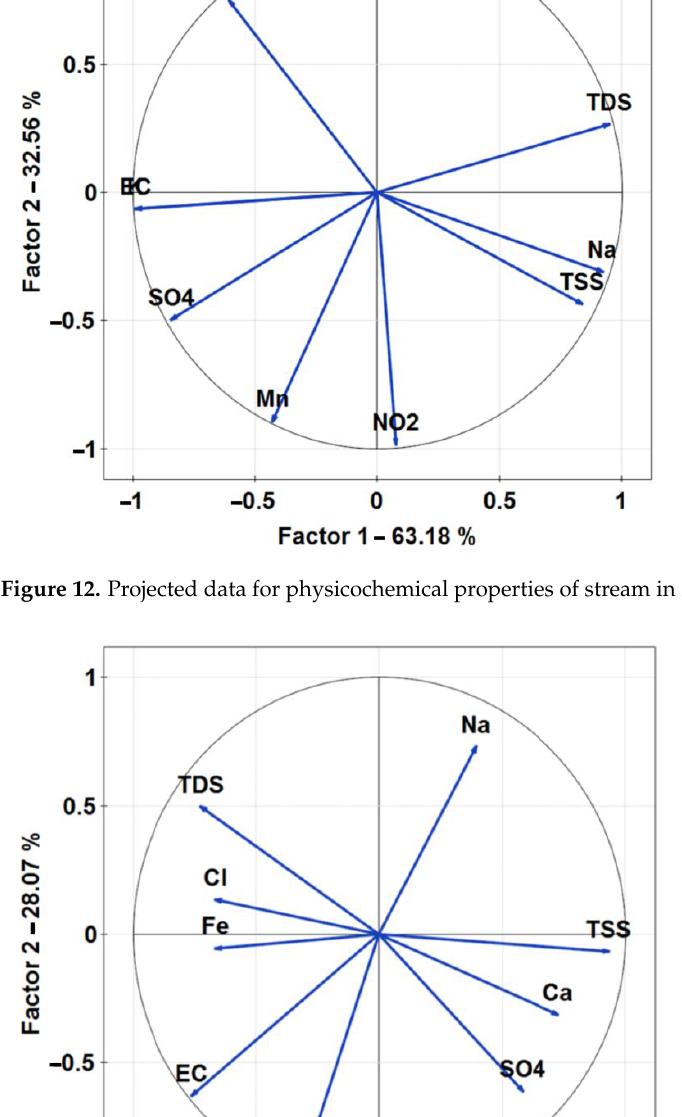
Figure 14. Projected data for physicochemical properties of stream in studied rural area using PCA. A hydrochemical evaluation of running waters, RHS adapted to the Polish conditions, was used as an assay supporting evaluation of water quality. Szoszkiewicz and Gebler (2011) conducted a statistical analysis on 950 sites all over Poland, analysed using the said method [61]. On the basis of the HMS indicator, they classified the rivers as modified (HMS > 45) and unmodified (HMS — from 0 to 2). The studies concerning the quality of water in small catchments using the same measurement methods and